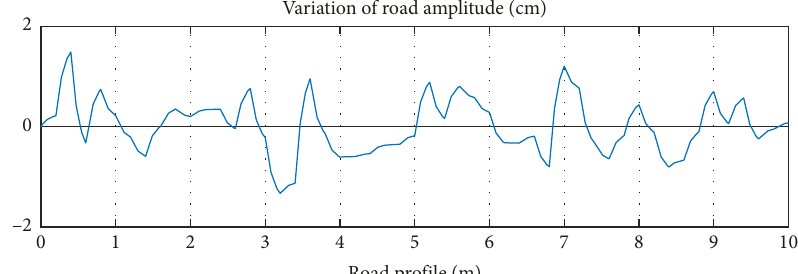
Figure 10: Road profile with length 1000m, sampled 10cm per measured point. Road profile PDF: min � − 2.319cm; max � 2.348cm; mean � 0.0131cm; median � 0.013 cm; variance �